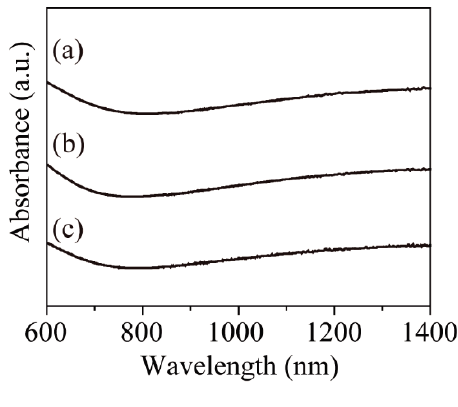
Figure 6. Vis-NIR spectra of ( a ) 6.6 ± 1.0 nm (1 h); ( b ) 13.0 ± 0.9 nm (3 h); and ( c ) 19.5 ± 1.7 nm (6 h) Fe O 3 4